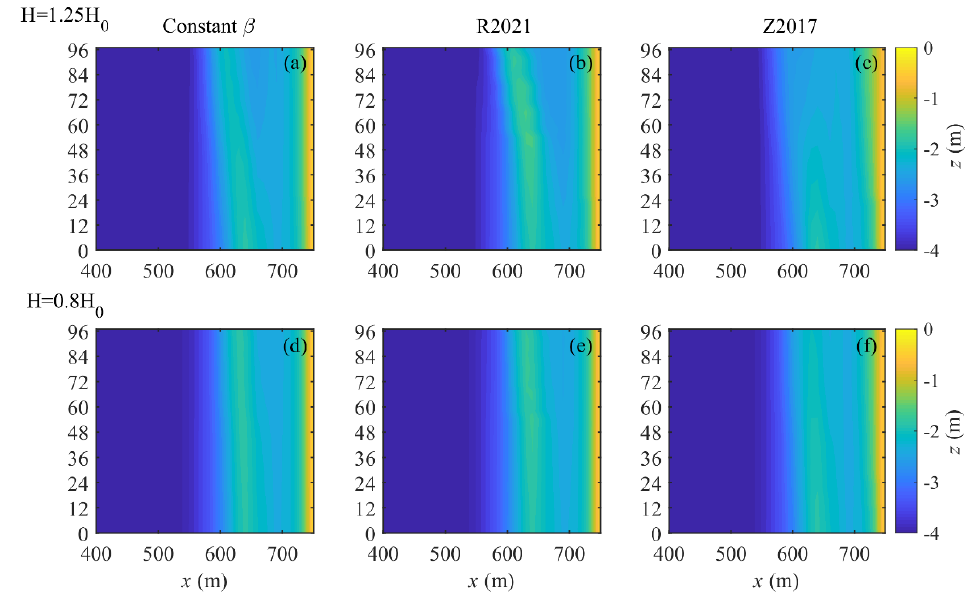
Figure 6. Spatial–temporal evolution of the sandbar predicted by constant roller slope ( a , d ) and the roller slope of R2021 ( b , e ) and Z2017 ( c , f ) under two different wave heights. Figure 6a–c are calculated with H = 1.25 H 0 , and Figure 6d–f are calculated with H = 0.8 H 0